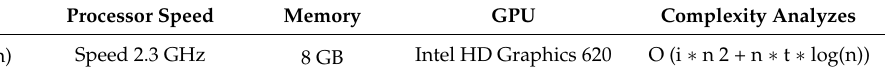
Table 10. Computer specifications.